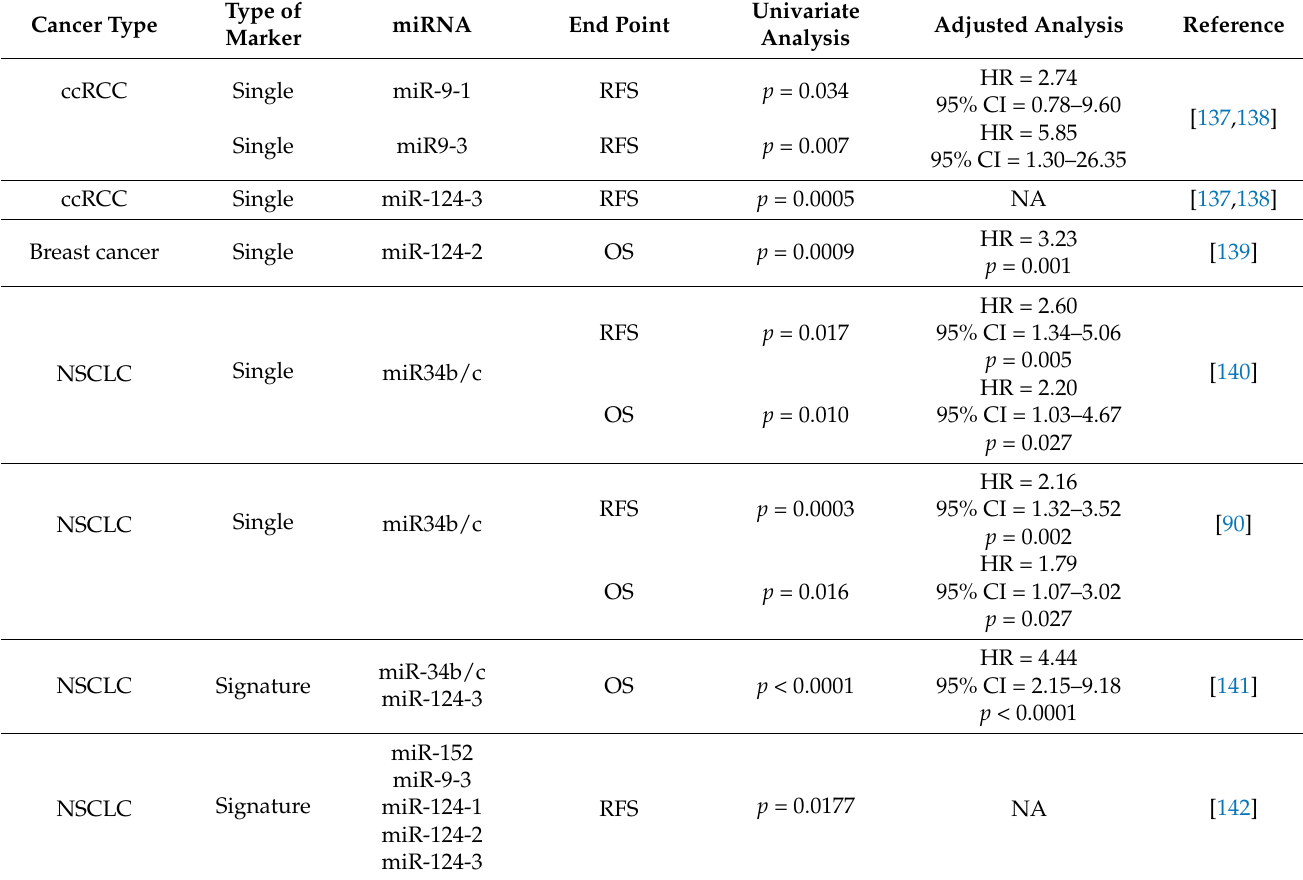
Table 3. miRNAs methylation as a biomarker for cancer